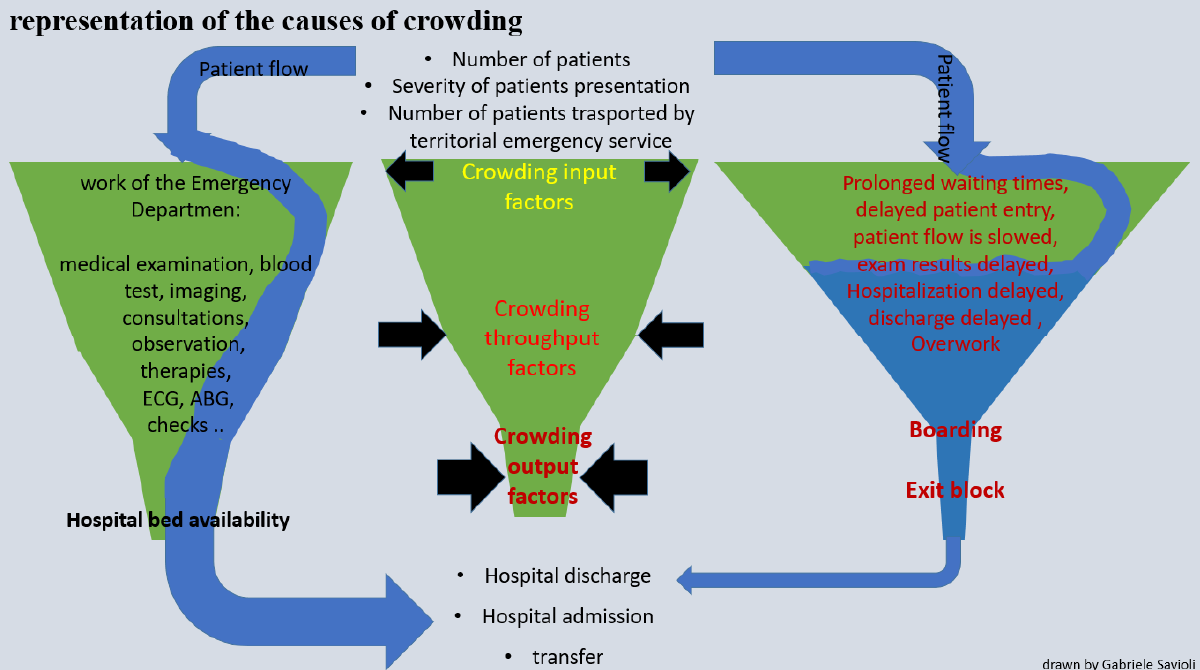
Figure 4. Graphic representation of the causes of crowding. This figure represents crowding in EDs. The ED is represented by a funnel. The volume of patients who present to the ED is represented by the water which enters the funnel (blue arrow). The input factors (number of incoming patients, number of serious incoming codes, number of patients arriving by ambulance) are a large part of the funnel input. The throughput factors (blood tests, imaging, instrumental tests, consultations, checks, number of staff on medical and nursing shifts, tight shifts) comprise the body of the funnel. The output factors (exit block, boarding) are represented by the neck of the funnel. In a normal situation (left column), the flow of patients (blue arrow) enters the ED (the funnel) and leaves after normal processing (medical examination performed, any blood, any imaging, any consultations). The times, imaginatively represented by the time required for water to flow through the funnel, are normal in this situation. The central column represents crowding or increases in input factors, as in the case of hyper-influx or simultaneous arrival of medically complex or critically ill patients (situation represented by an enlarged funnel base), or due to internal factors, such as presentation of medically complex patients who require prolonged stabilization or numerous medical procedures (as represented by an enlarged funnel body) or for the worsening of the outgoing factors, as is necessary in the case of exit block (situation represented in this case by a restricted funnel neck). The resulting situation (right column) sees a global and marked slowdown in patient flow (blue arrow) and prolongation of time points (waiting, process, LOS). Normally, the outgoing flow is wider. In cases of crowding, it is markedly slowed, as represented by a thinner blue arrow at the